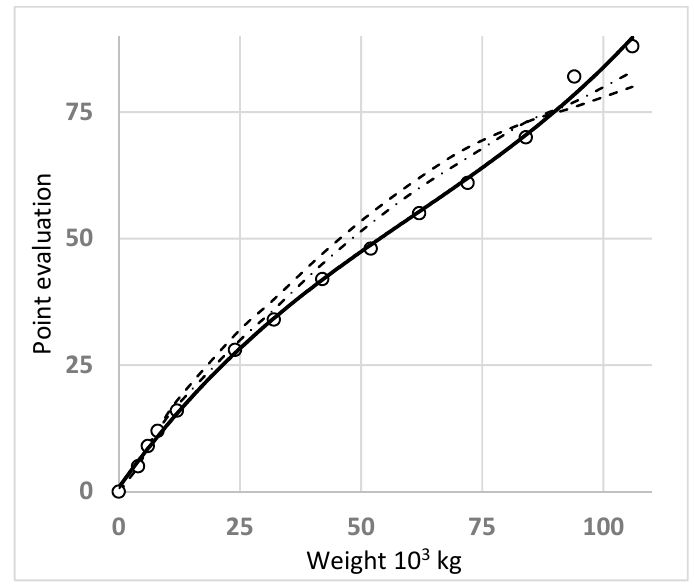
Figure 7. Graphical evaluation of the approximation results of the point evaluation on the weight of machines. Source: authors.